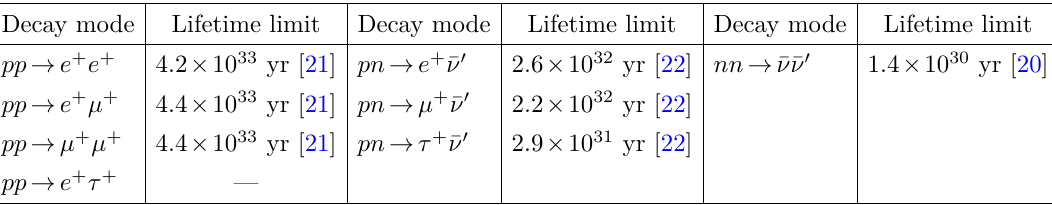
Table 1 . The lower bound on the partial lifetime of the dinucleon to dilepton transitions. Where the limits for the charged modes ( pp ) and ( pn ) were set per oxygen nucleus 16 O in water Cherenkov Super-K experiment at 90% confidence level [21, 22] while the limit on the neutral mode ( nn ) is obtained from the carbon nucleus 12 C in KamLAND experiment [20]. The bounds on modes involving anti-neutrinos are also valid for the cases with neutrinos since they are treated as invisible states in the experimental search.